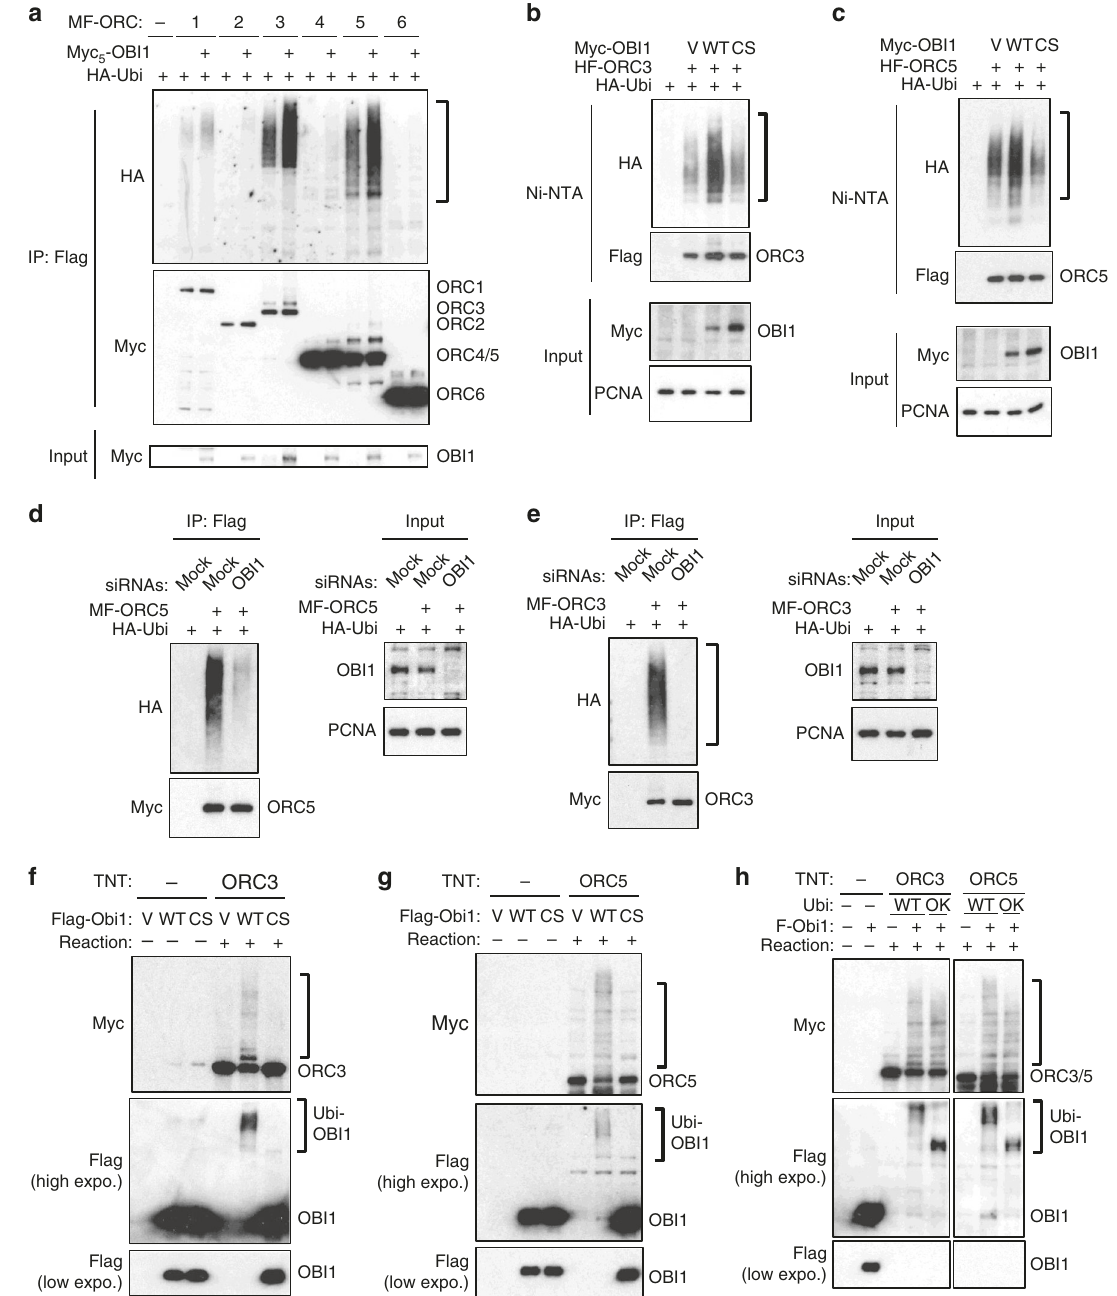
Fig. 4 OBI1 catalyses ORC3 and ORC5 multi-mono-ubiquitylation. a U2OS cells were co-transfected with the indicated Myc-Flag (MF)-tagged ORC subunits and HA-tagged ubiquitin. When indicated ( + ), Myc-tagged OBI1 was also co-expressed. Two days post-transfection, cells were lysed in NEM- containing lysis buffer and tagged proteins were puri fi ed by anti-Flag immunoprecipitation. Expression and ubiquitin conjugation of the immunoprecipitates were monitored by western blotting, as indicated. Myc-OBI1 expression was also analysed in input extracts. b , c U2OS cells were co-transfected with His 6 - Flag-ORC3 (HF-ORC3) or His 6 -Flag-ORC5 (HF-ORC5) and either wild type (WT) or inactive (CS) Myc-OBI1 along with HA-ubiquitin as indicated. ORC3/5 ubiquitylation was detected by puri fi cation in denaturing conditions on nickel beads (Ni-NTA). Expression and ubiquitin conjugation of the isolated proteins were monitored by western blotting. Myc-OBI1 expression was also analysed in input extracts. d , e U2OS cells were transfected with Mock or OBI1 -speci fi c siRNAs. The next day, cells were co-transfected with Myc-Flag (MF)-tagged ORC3 or ORC5 and HA-tagged ubiquitin, as indicated. Ubiquitylation was detected 2 days later as in a . Expression of endogenous OBI1 was monitored in input extracts by western blotting. f , g OBI1 in vitro assay. U2OS cells were transfected with wild type Flag-OBI1 (WT) or inactive mutant (CS) for two days. Immunoprecipitated OBI1 (IP: Flag) was incubated with in vitro translated Myc-ORC3 or -ORC5 along with E1, E2 (UbcH5a), ubiquitin and ATP for 30 min. at 37 °C. Tagged proteins were detected by western blotting as indicated. h OBI1 in vitro assay performed as in f , g , but with wild type (WT) or lysine-less (0 K) ubiquitin. Tagged proteins were detected by western blotting